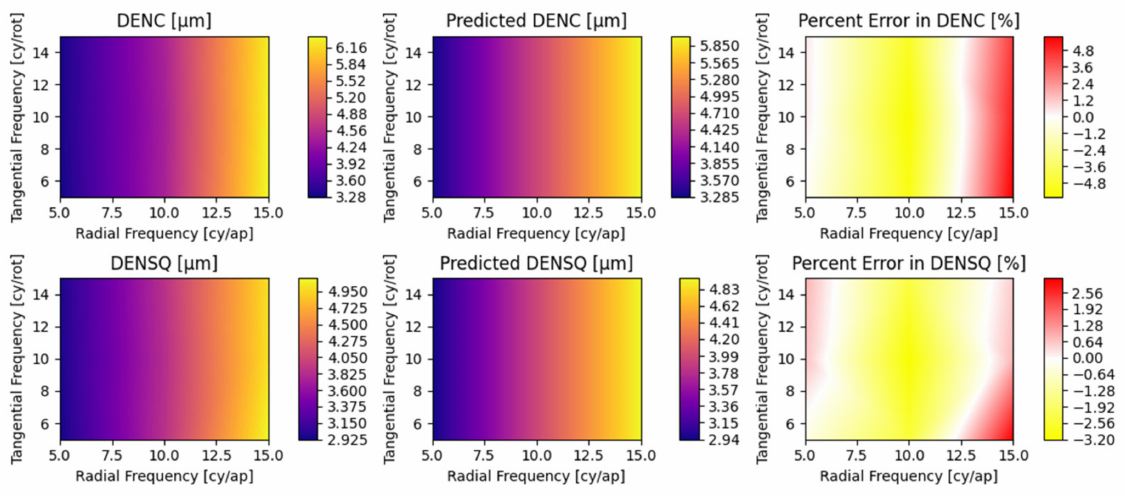
Figure A9. Radial Frequency versus tangential frequency. ( η = ζ = δ = 0, κ = 0.15, σ = 0.05, θ = 0 ◦ ).